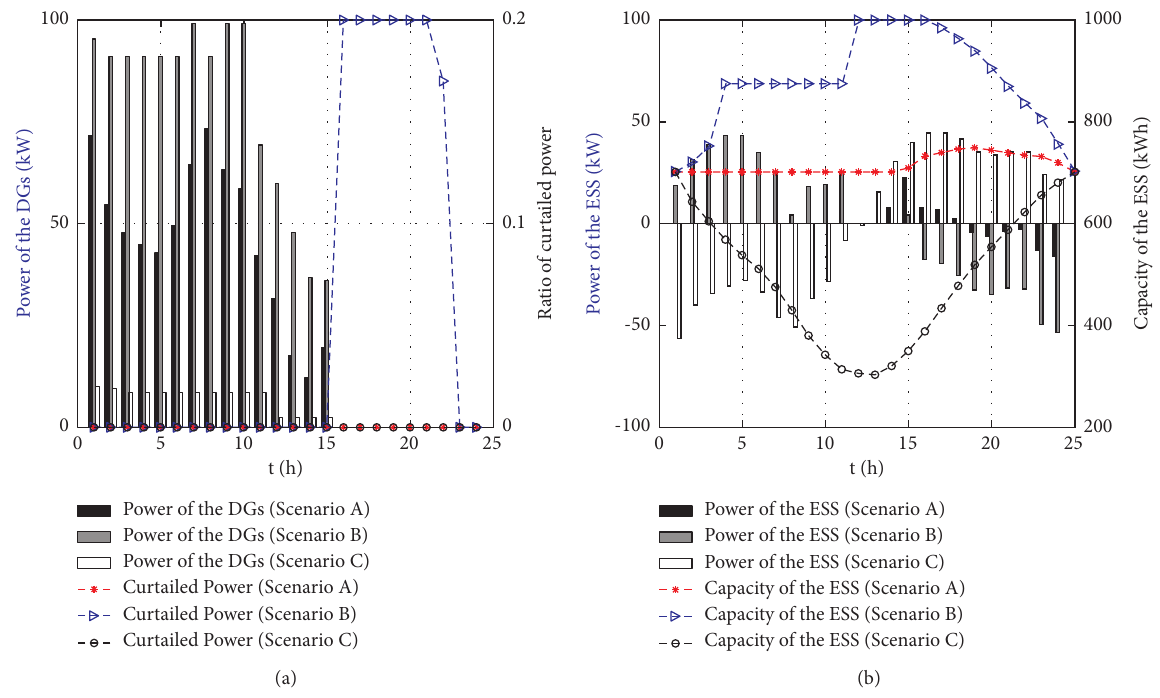
Figure 3: System behaviour under three scenarios. (a) Behaviour of the DGs and load. (b) Behaviour of the ESS. Table 10: Comparison of costs obtained using two models under three classical scenarios for various Γ Predispatch cost ( € ) Γ T